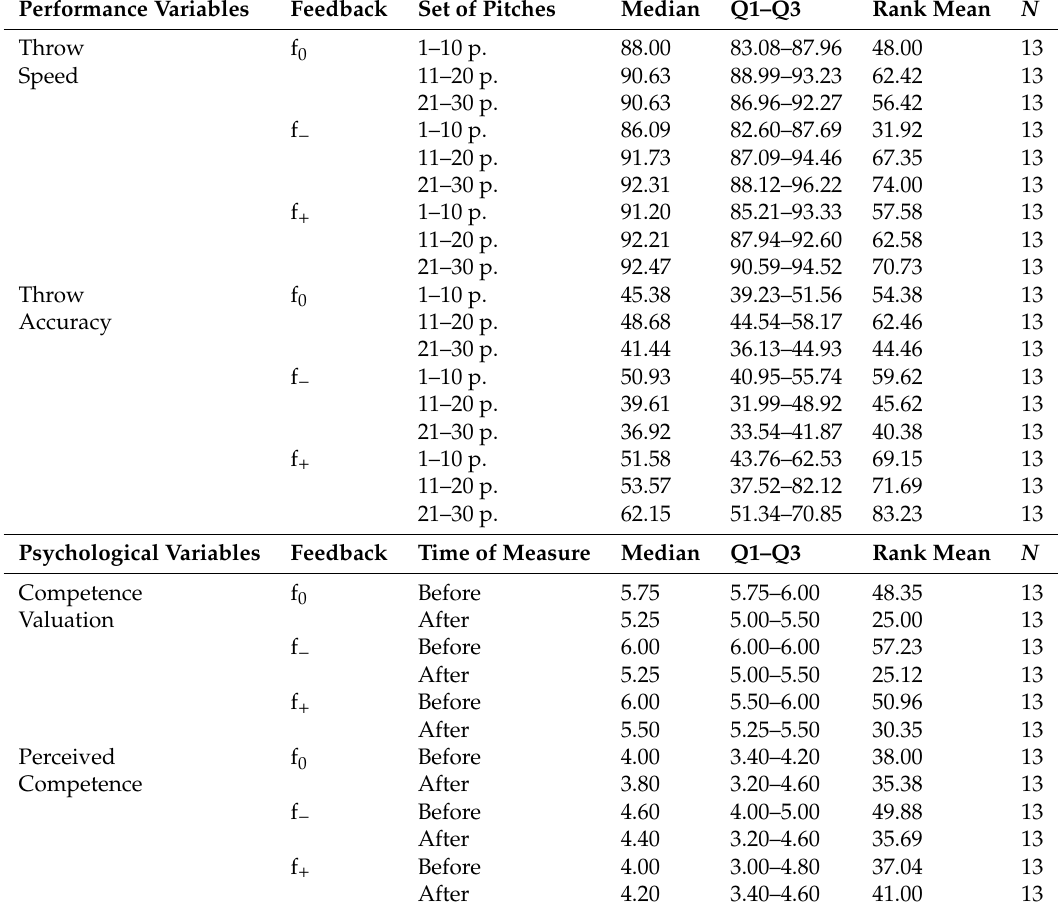
Table 1. Descriptive information of psychological and performance